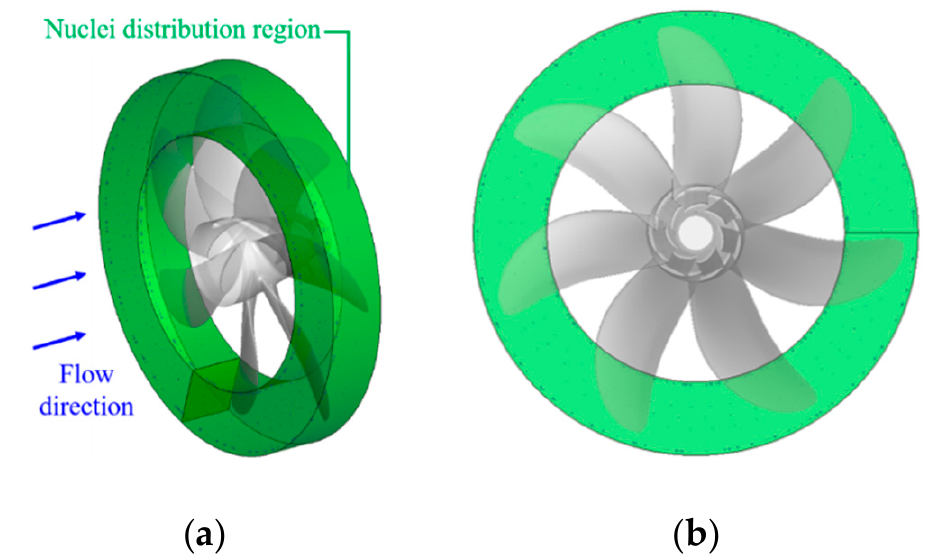
Figure 18. Domain for nuclei distribution in the flow field: ( a ) iso-metric view; ( b ) front-view Appl. Sci. 2020 , 10 , x FOR PEER REVIEW